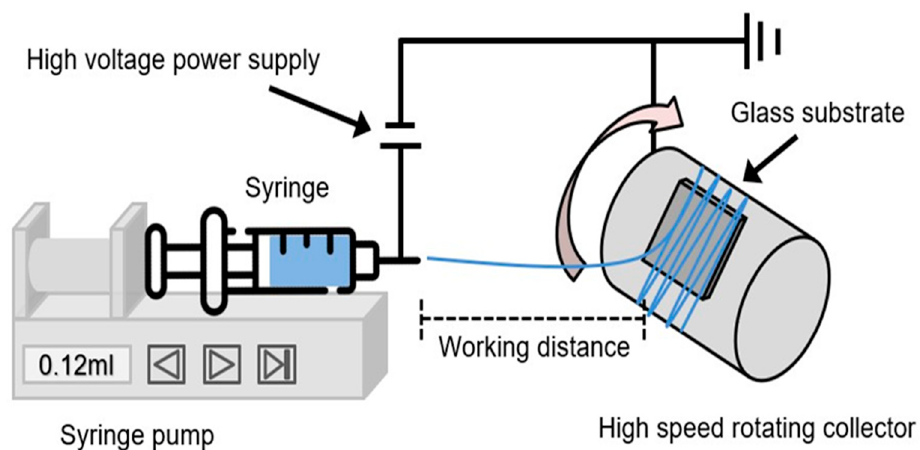
Figure 1. Schematic image of electrospinning experimental setup.